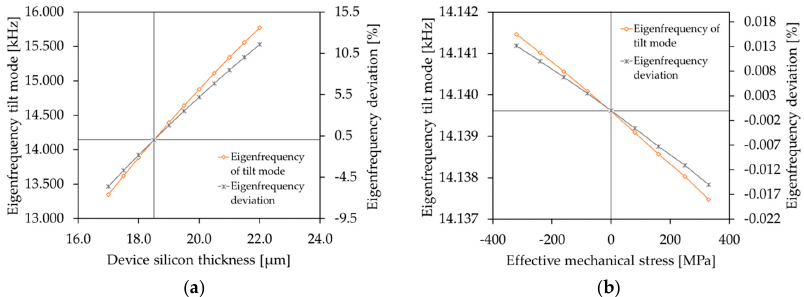
Figure 6. Comparison of the simulated influences on the eigenfrequency of the tilt mode (Design 1): ( a ) eigenfrequency and eigenfrequency deviation (deviation with respect to the eigenfrequency at 18.5 µm) versus device silicon thickness; ( b ) eigenfrequency and eigenfrequency deviation (deviation with respect to the zero stress level) versus the effective mechanical stress.